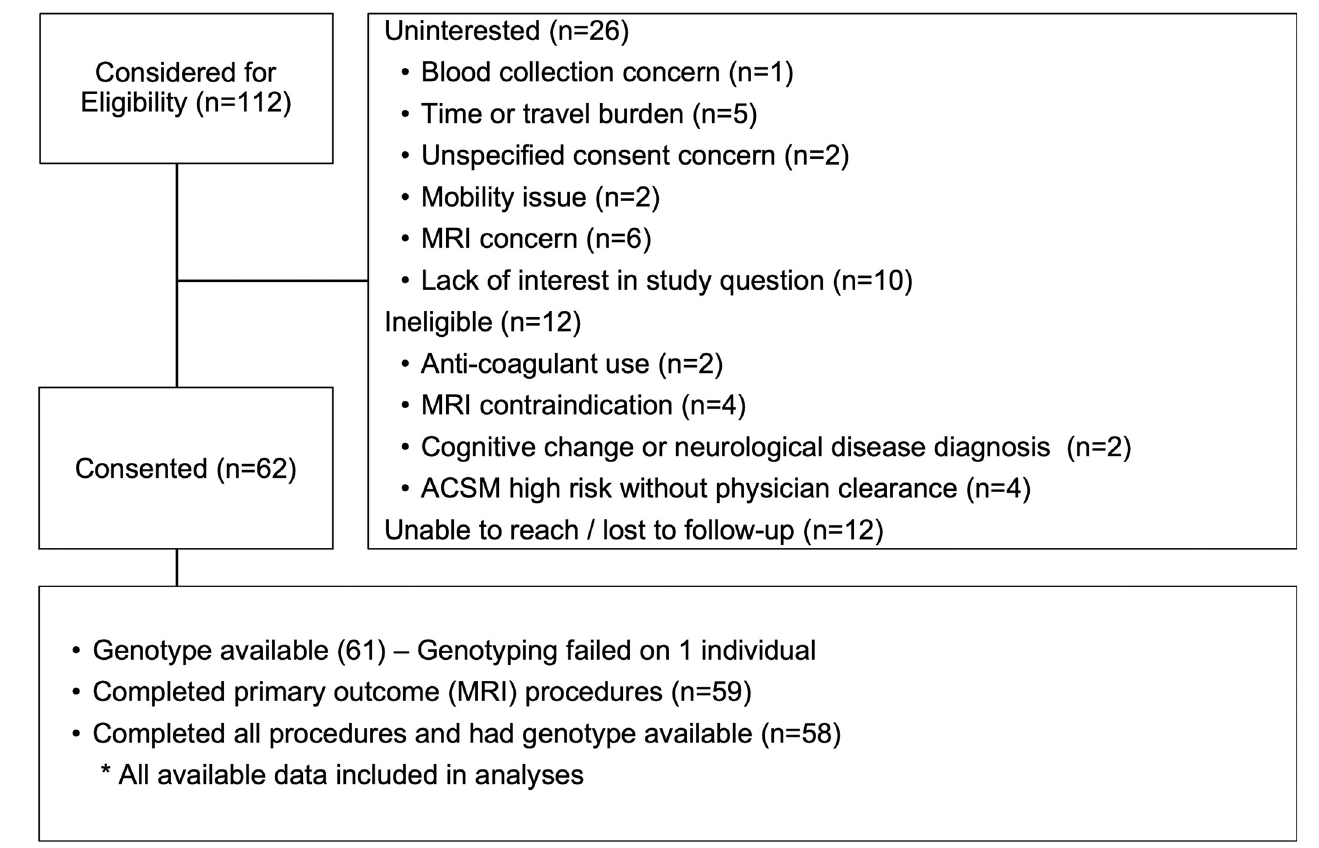
Fig 1. CONSORT enrollment